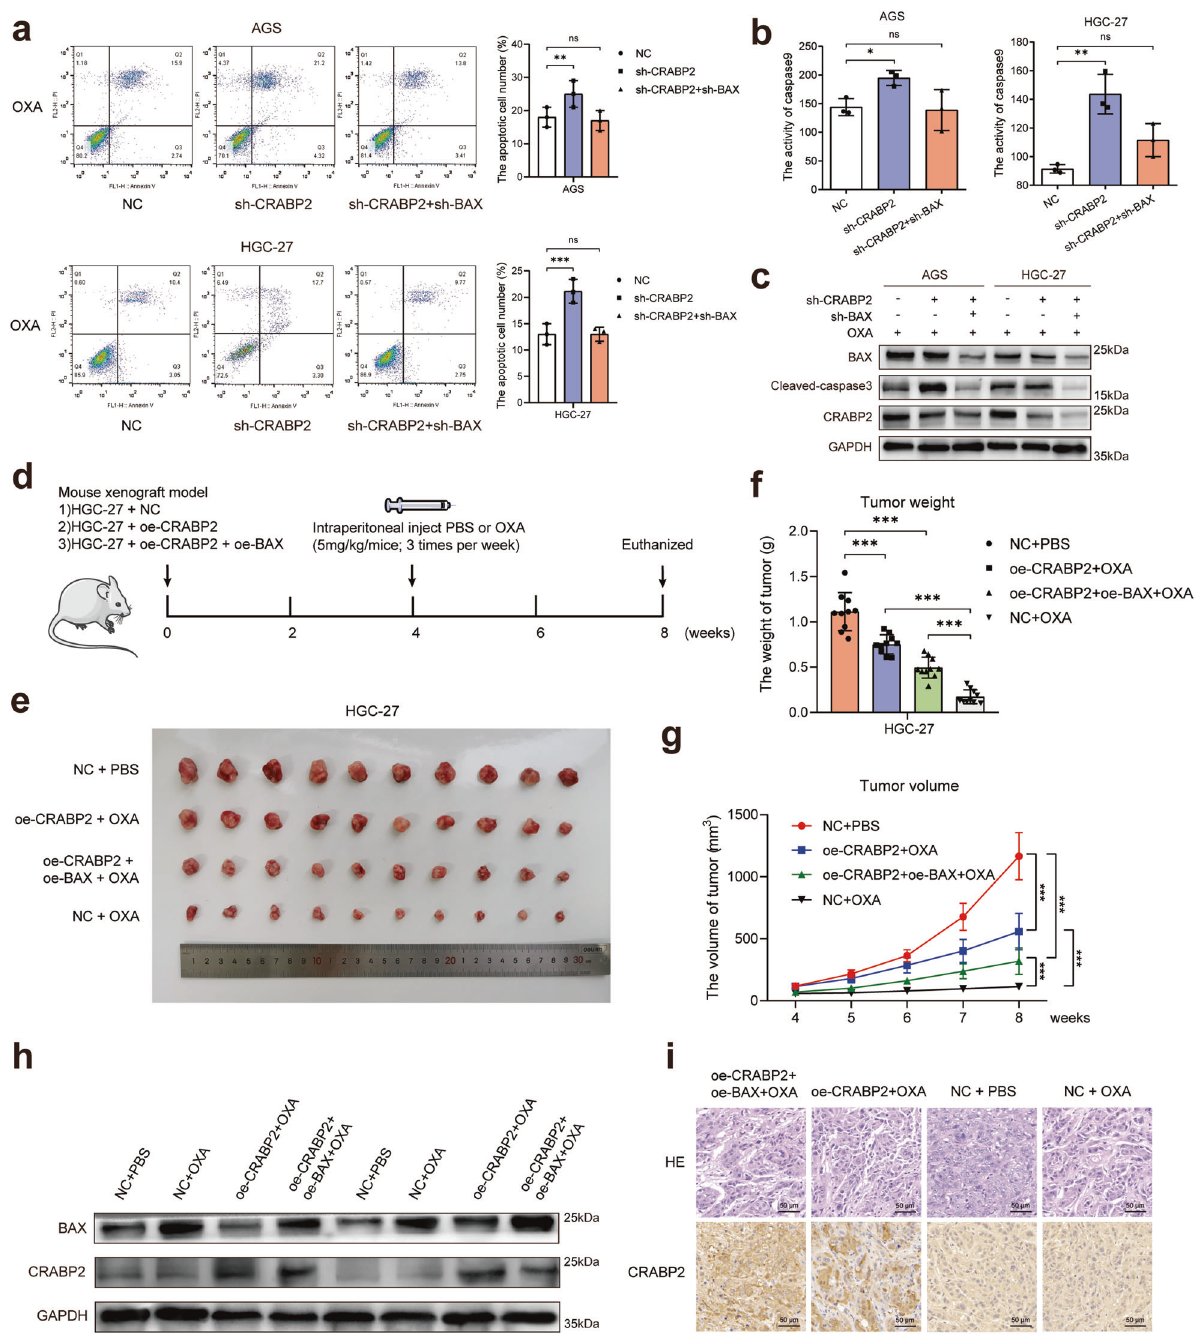
Fig. 5 CRABP2 promoted oxaliplatin resistance through the BAX-dependent cell apoptosis pathway. a After knocking down CRABP2/ BAX and adding OXA (concentration: AGS 0.2 μ M, HGC-27 0.4 μ M), the percentage of apoptotic cells was examined by fl ow cytometry. b After knocking down CRABP2/ BAX and adding OXA (concentration: AGS 0.2 μ M, HGC-27 0.4 μ M), the activity of cleaved caspase 9 was examined. c After knocking down CRABP2/ BAX and adding OXA (concentration: AGS 0.2 μ M, HGC-27 0.4 μ M), the expression of cleaved caspase 3/BAX/ CRABP2 was examined by western blotting. d Schematic diagram of the experimental procedures of the cell-derived xenograft model in nude mice. e Photo showing tumor formation in the four groups of nude mice. Tumor weight ( f ) and tumor volumes ( g ) of four groups of nude mice. h The expression of CRABP2 and BAX in tumors from four groups of nude mice by western blotting. i HE and CRABP2 IHC staining of tumors in four groups of nude mice. All experiments were performed in three replicates. * P < 0.05, ** P < 0.01, *** P < 0.001. with a mouse-derived CRABP2 (ProteinTech, Cat. #66468-1-Ig) primary antibody with green fl uorescence were incubated at room temperature for antibody/ rabbit-derived BAX (ProteinTech, Cat. #50599-2-lg) primary 1 h and washed three times with PBS. The slides were stained with DAPI antibody/ mouse-derived BAX (ProteinTech, Cat. #60267-1-Ig) primary (Thermo Fisher, MA, USA) for 5 min and washed three times with PBS. antibody/rabbit-derived PARKIN (ProteinTech, Cat. #14060-1-AP) primary Then, the slides were transferred to carrier glass, and the slides were antibody overnight. The rabbit-derived fl uorescent secondary antibody photographed by confocal microscopy LSM980 (Carl Zeiss AG, Oberko- with red fl uorescence and the mouse-derived fl uorescent secondary chen, Germany). Cell Death and Disease (2022)